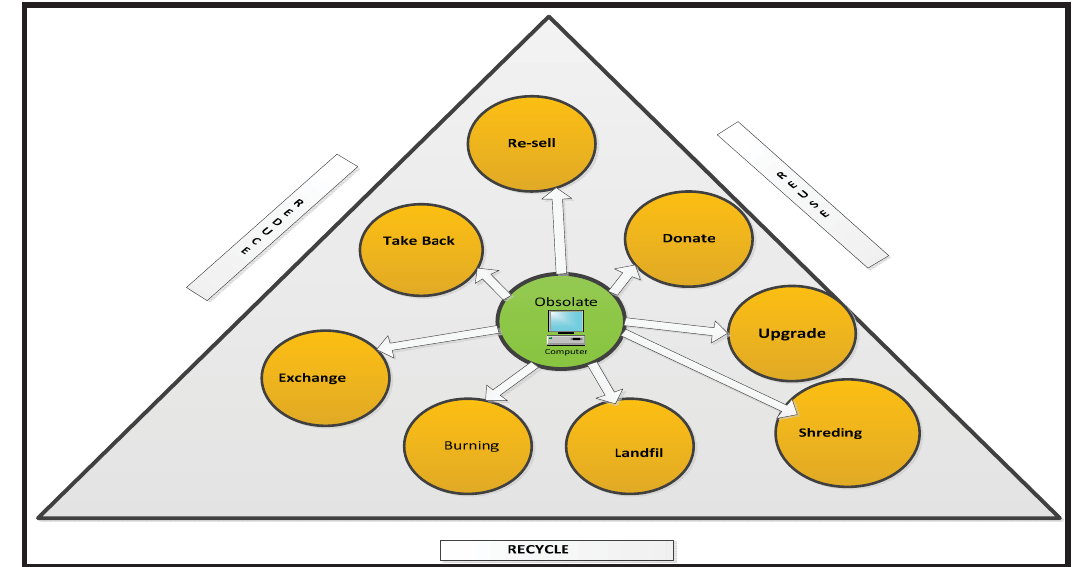
Fig. 1. A proposed Disposal of Obsolete Computers Framework